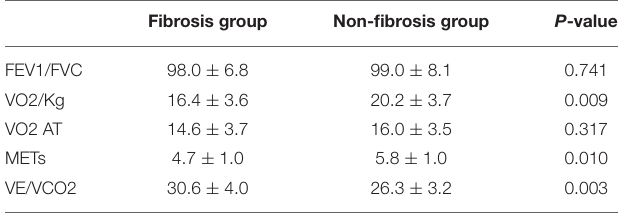
TABLE 5 | Results of cardiopulmonary exercise testing on patients with COVID-19. Fibrosis group Non-fibrosis group P